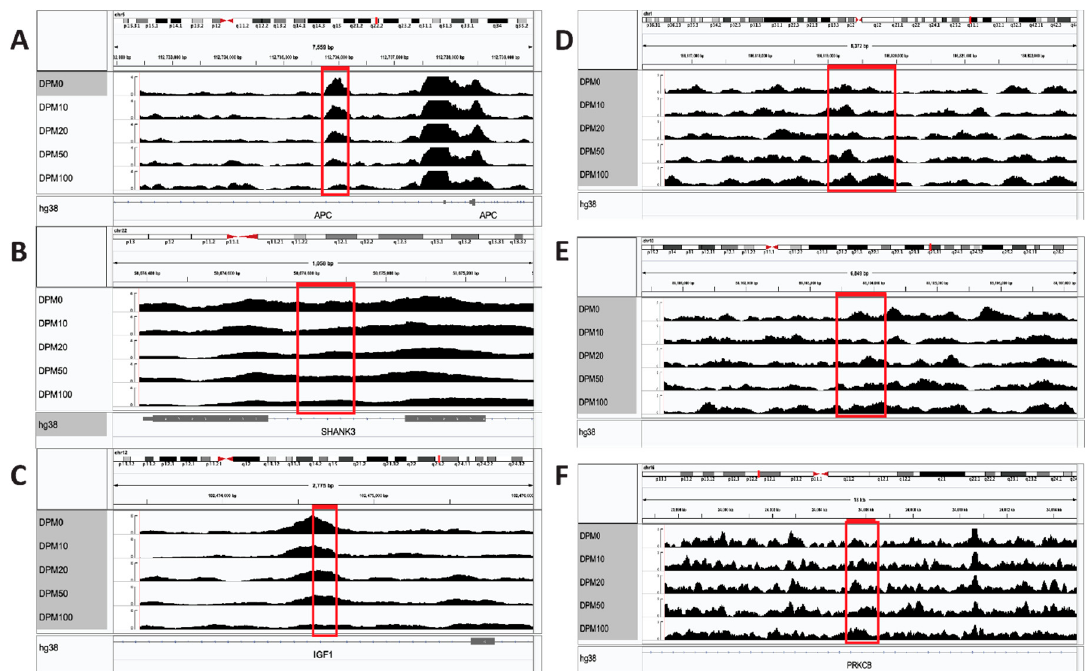
Figure 2. Top gene enhancers that are differentially accessible when exposed to increasing doses of diesel particulate matter (DPM). A – C: three enhancer regions that have negative log2FC in chromatin accessibility compared to the control following increasing DPM exposure, and are associated with genes APC ( A ), SHANK3 ( B ), and IGF1 ( C ). D – F: the enhancer regions with positive log2FC compared to the control following increasing DPM exposure, and are associated with the genes PTGS2 ( D ), PTEN ( E ), and PRKCB ( F ). Both the enhancers for PTGS2 ( D ) and PTEN ( E ) are located in the distal intergenic region.